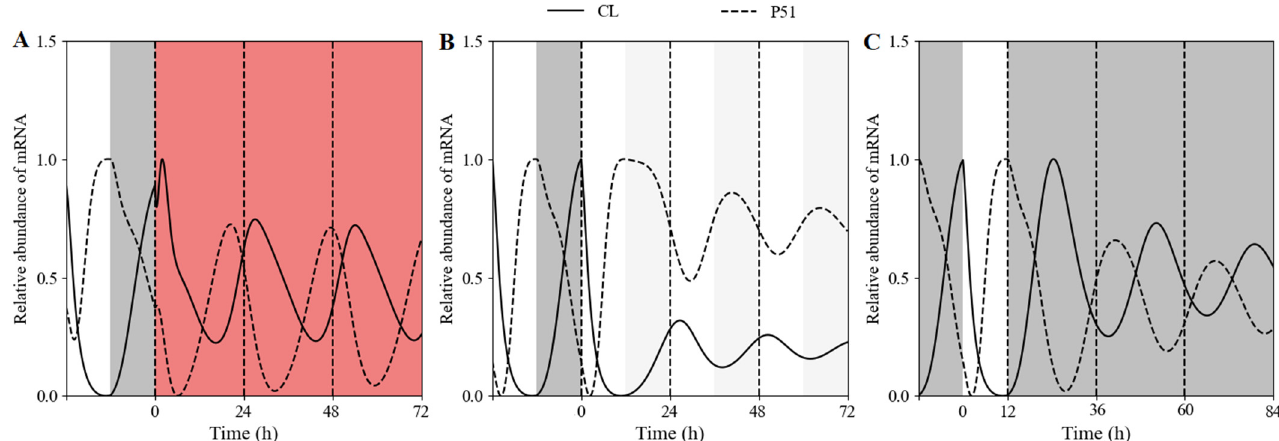
Figure 5. The temporal evolution of circadian clock in free-running period. The WT lines were entrained in white-light/dark cycles (12 h light/12 h dark) for 5 d, and then, transferred to 24 h constant light on day 5. ( A ) The WT lines were transferred into RR at ZT0. ( B ) The WT lines were transferred into LL at ZT0. ( C ) The WT lines were transferred into DD at ZT12. The grey, red, and white bands represent subjective continuous darkness (DD), constant red light (RR), and constant white light (LL), respectively. The solid and dashed lines represent the simulated transcript levels of CL ( CCA1 / LHY ) and P51 ( PRR5 / TOC1 ) under different free-running conditions. All values are normalized to their respective